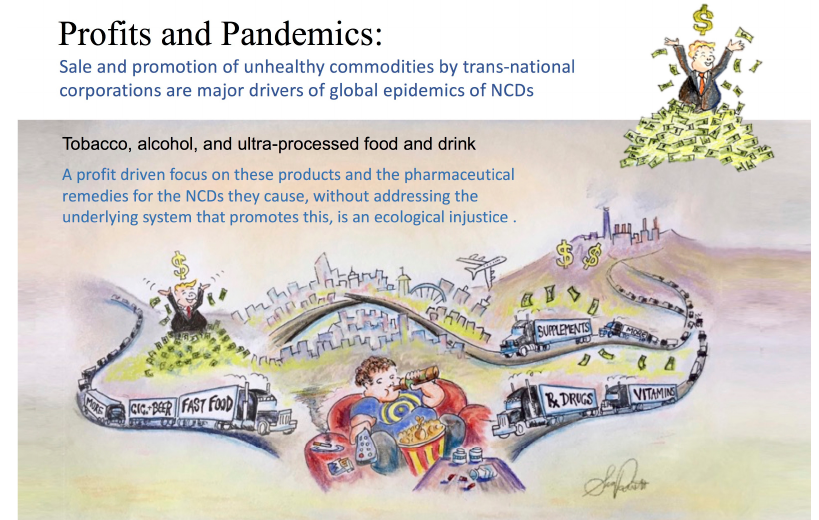
Figure 4. Transnational corporations profit from unhealthy commodities which directly contribute to health disparities in disadvantaged communities. These industries should have no role in the formation of health policy. There is no evidence that public-private partnerships are effective. Public regulation and market intervention are the only evidence-based measures (see